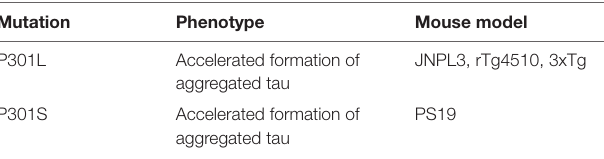
TABLE 4 | Representative missense mutations linked to tauopathies used in model mice.